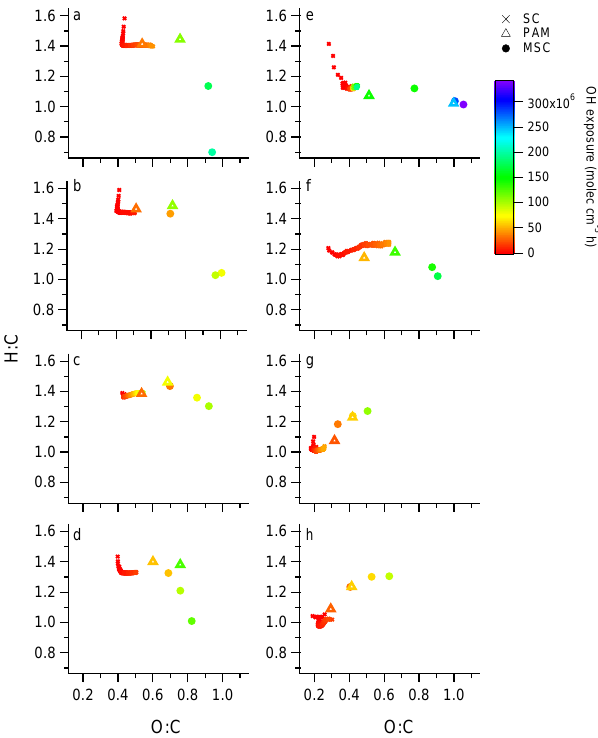
Figure 6. Elemental ratios of SOA generated during each wood- burning experiment ( a–h , experiments 5–12, respectively) as a func- tion of OH exposure. Data points correspond to the SC and the PAM and MSC when sampling from the